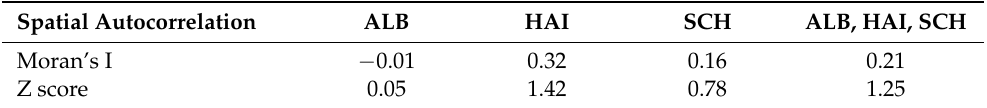
Table 7. Moran’s I results for structural diversity across the three exploratories. For z-score values between ± 1.65 random distribution of samples can be assumed.